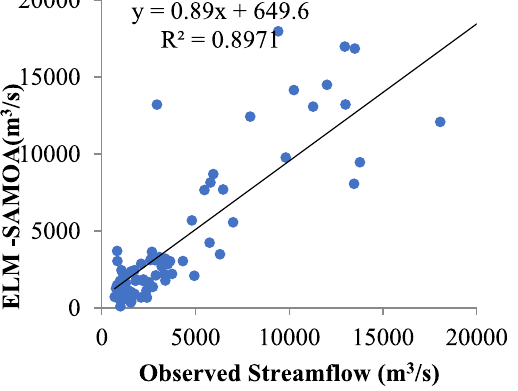
Fig. 7 Scatterplots of the observed and predicted streamflows different ELM-based models in the test period of